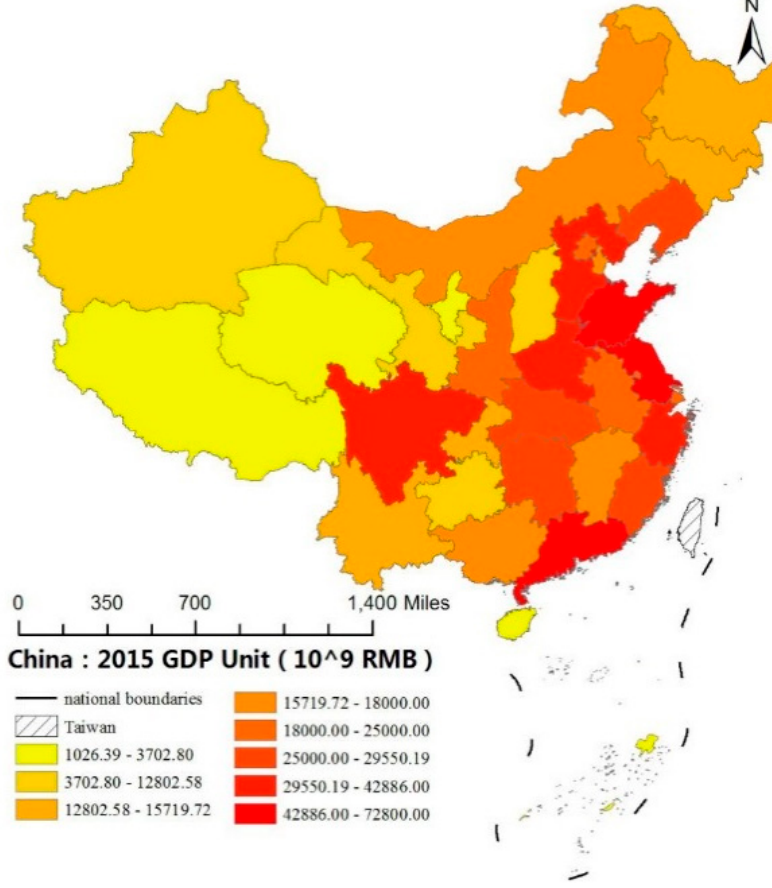
Figure 2. China’s Provincial GDP in 2015; (Note: Ren Ming Bi (RMB), is the Mandarin ping yin (spelling) for China Yuan (CNY). This study includes total 30 Provinces and Municipalities of China, excluding Hong Kong, Macau, Taiwan, and Tibet).